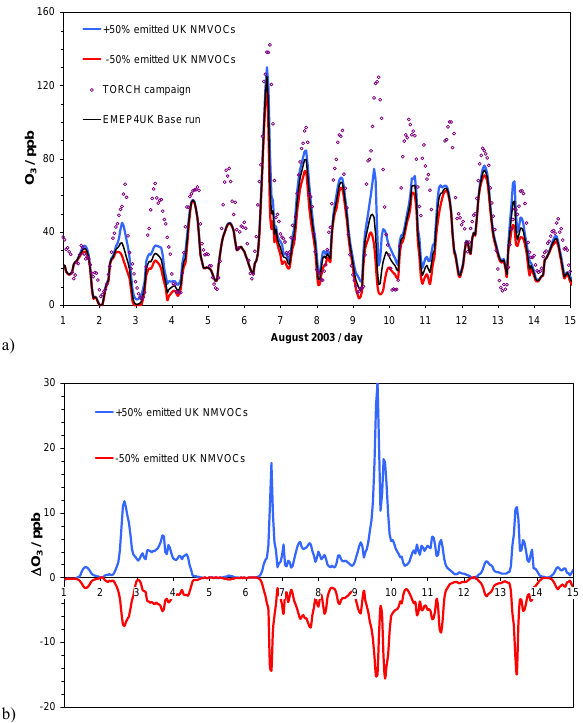
Figure 9: As for Figure 8 but for model sensitivity experiments varying the emissions of UK Fig. 9. As for Fig. 8 but for model sensitivity experiments varying anthropogenic NMVOC (+50%, blue; -50%, red). the emissions of UK anthropogenic NMVOC (+50%, blue; − 50%, red).